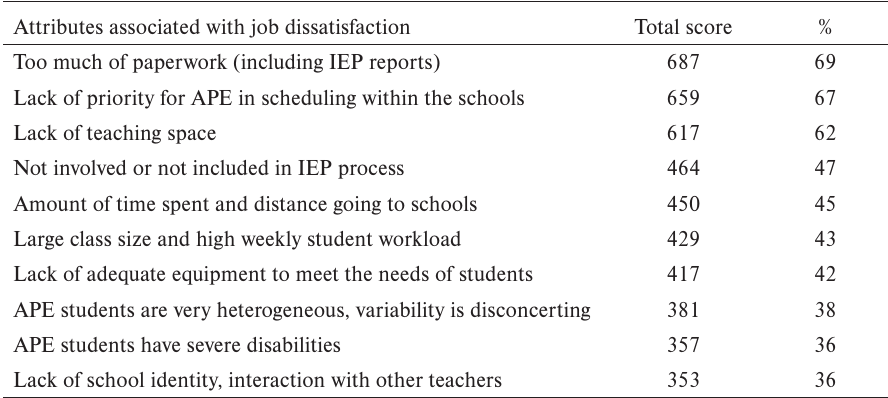
Ranking of Herzberg factors attributed to job dissatisfaction for CAPES Attributes associated with job dissatisfaction Total score % Working conditions 644 Company policies and administration Interpersonal relationship with supervisors Supervision in technical, instructional and planning matters Salary 404 Interpersonal relationship with paraprofessionals/aids 404 Benefits of job (health insurance, retirement plan, etc.) Interpersonal relationship with peers 293 Job security 245 27 Note. Range of possible answers scores is related to number of items in pairwise comparison and total number of respondents as each attribute is compared with all other attributes on the list. There- fore for the comparison of nine attributes maximum score (representing maximum dissatisfaction) is 9 × 113 = 1017.